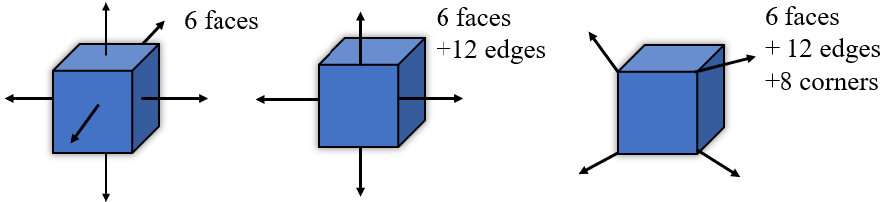
Figure 3. Voxel Figure 3. Voxel connectivity.